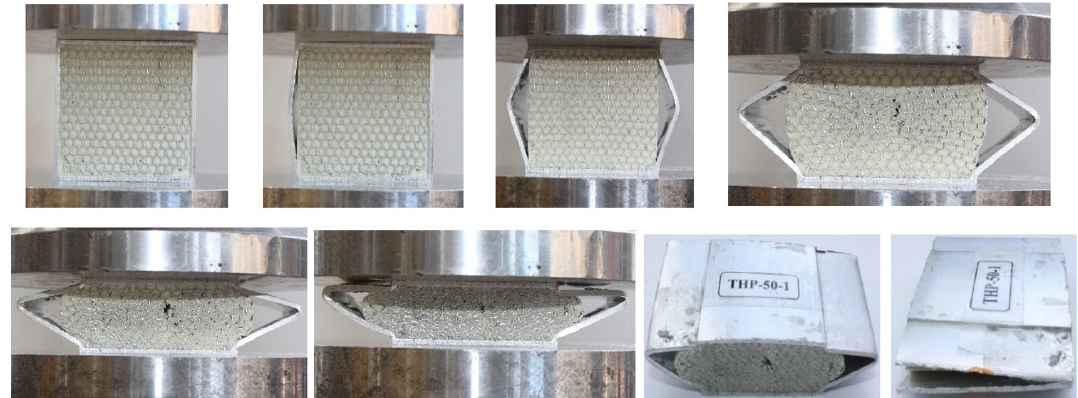
Figure 10. Stages of failure mode of a tube filled with mixed core (Pu foam and honeycomb) laterally